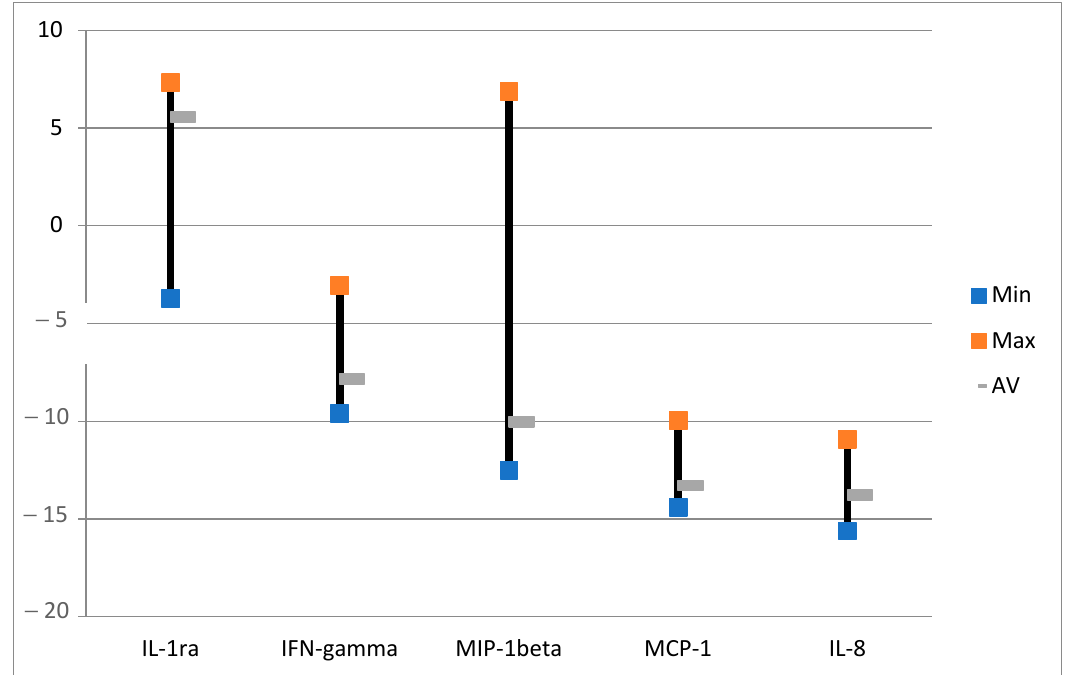
Figure 6. Effects of ALA and red light on selected cytokines with the lowest variabilities. The data are presented as minimal, maximal, and average log values. Log = sgn (PDT i − ALA i )*log 2 (|PDT i − ALA i |), where PDT i is the cytokine fluorescence intensity in the PDT group with ALA plus light and ALA i is the cytokine fluorescence intensity in the control group with ALA alone.